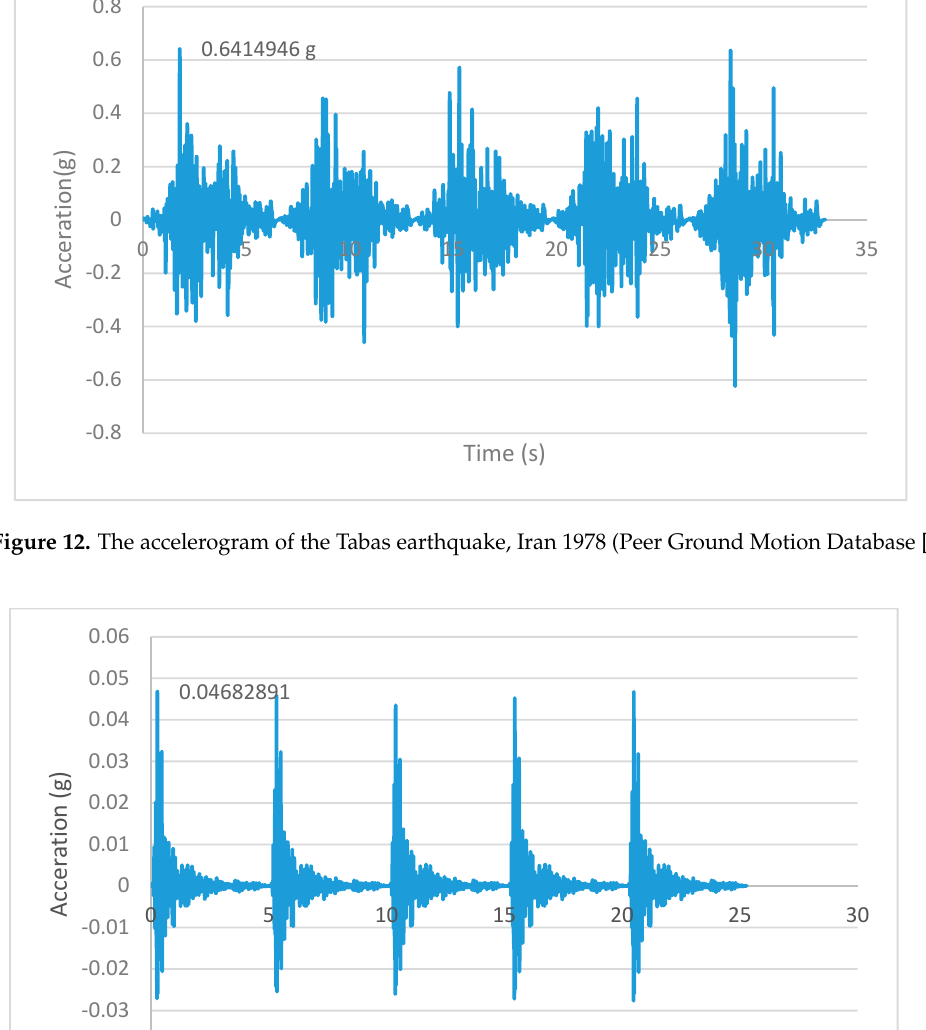
Figure 11. The X-displacement series of the Friuli earthquake, Italy 1981 (Peer Ground Motion Database [43]).